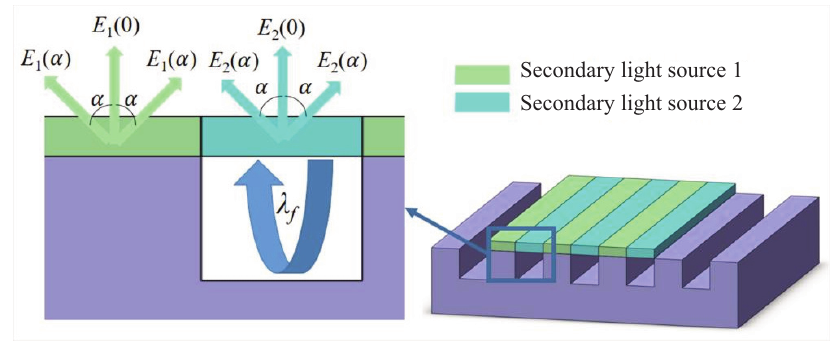
Fig. 1. Dual light source array model for metallic